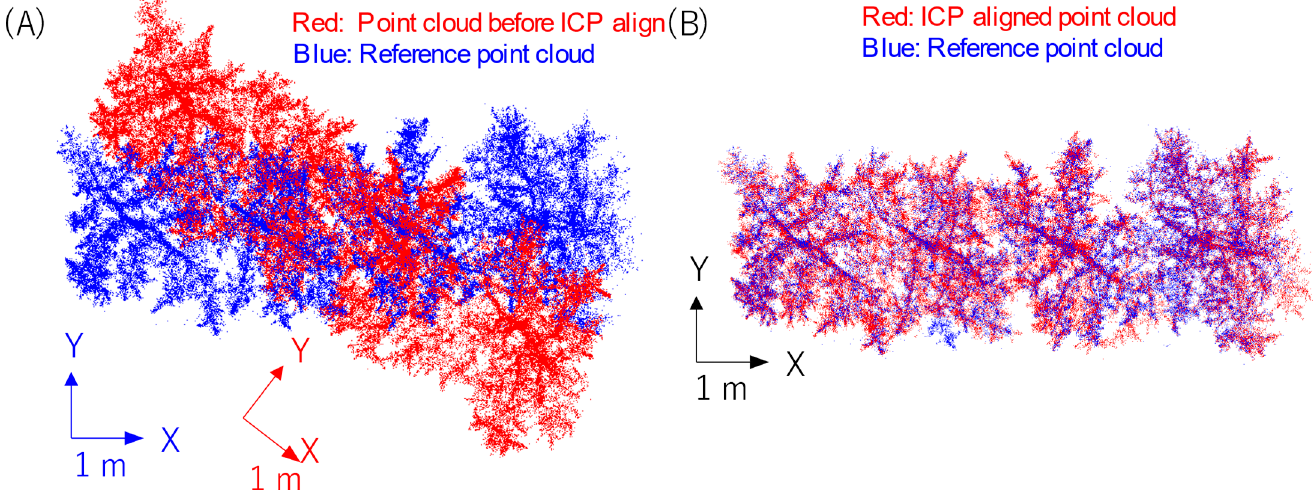
Figure 4. ICP processing work between the different point clouds: ( A ) point clouds before ICP processing; ( B ) point clouds after ICP processing.